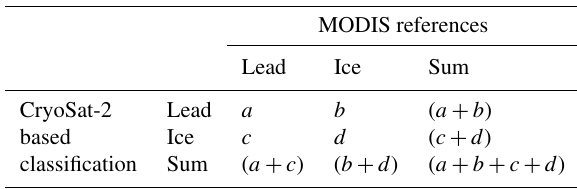
Table 1. Error matrix for calculation of user, producer and overall accuracy in terms of lead and ice